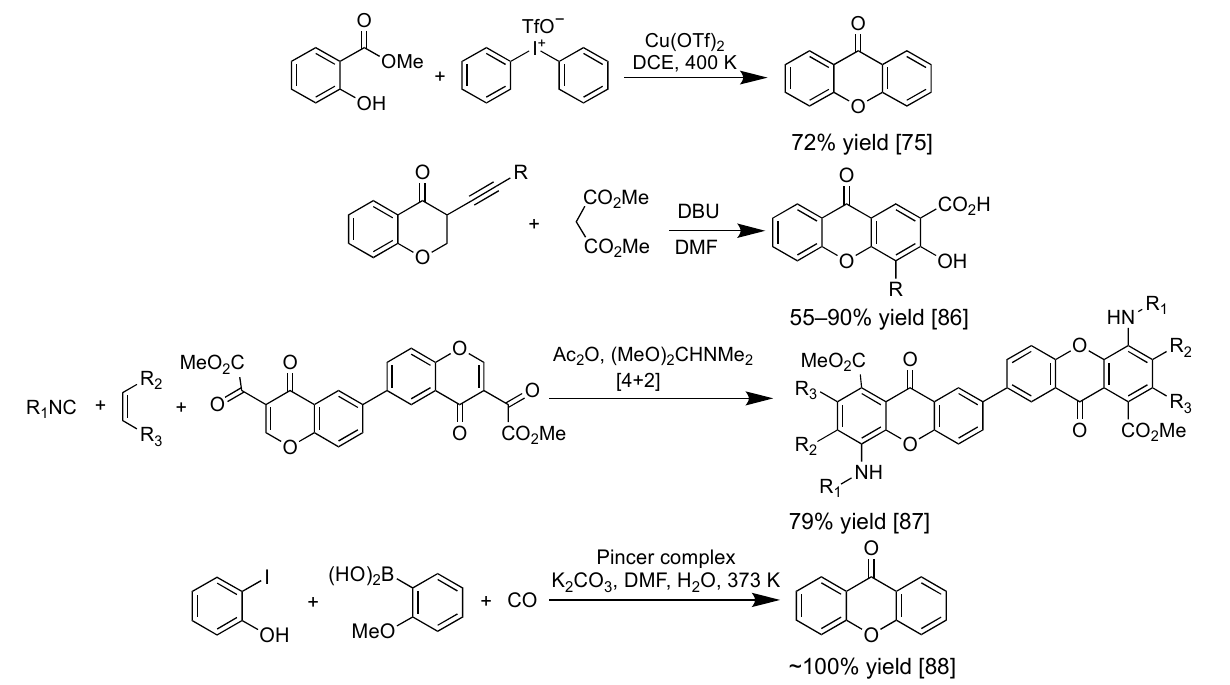
Figure 8. Recent examples of the multireagent synthesis of xanthone derivatives.